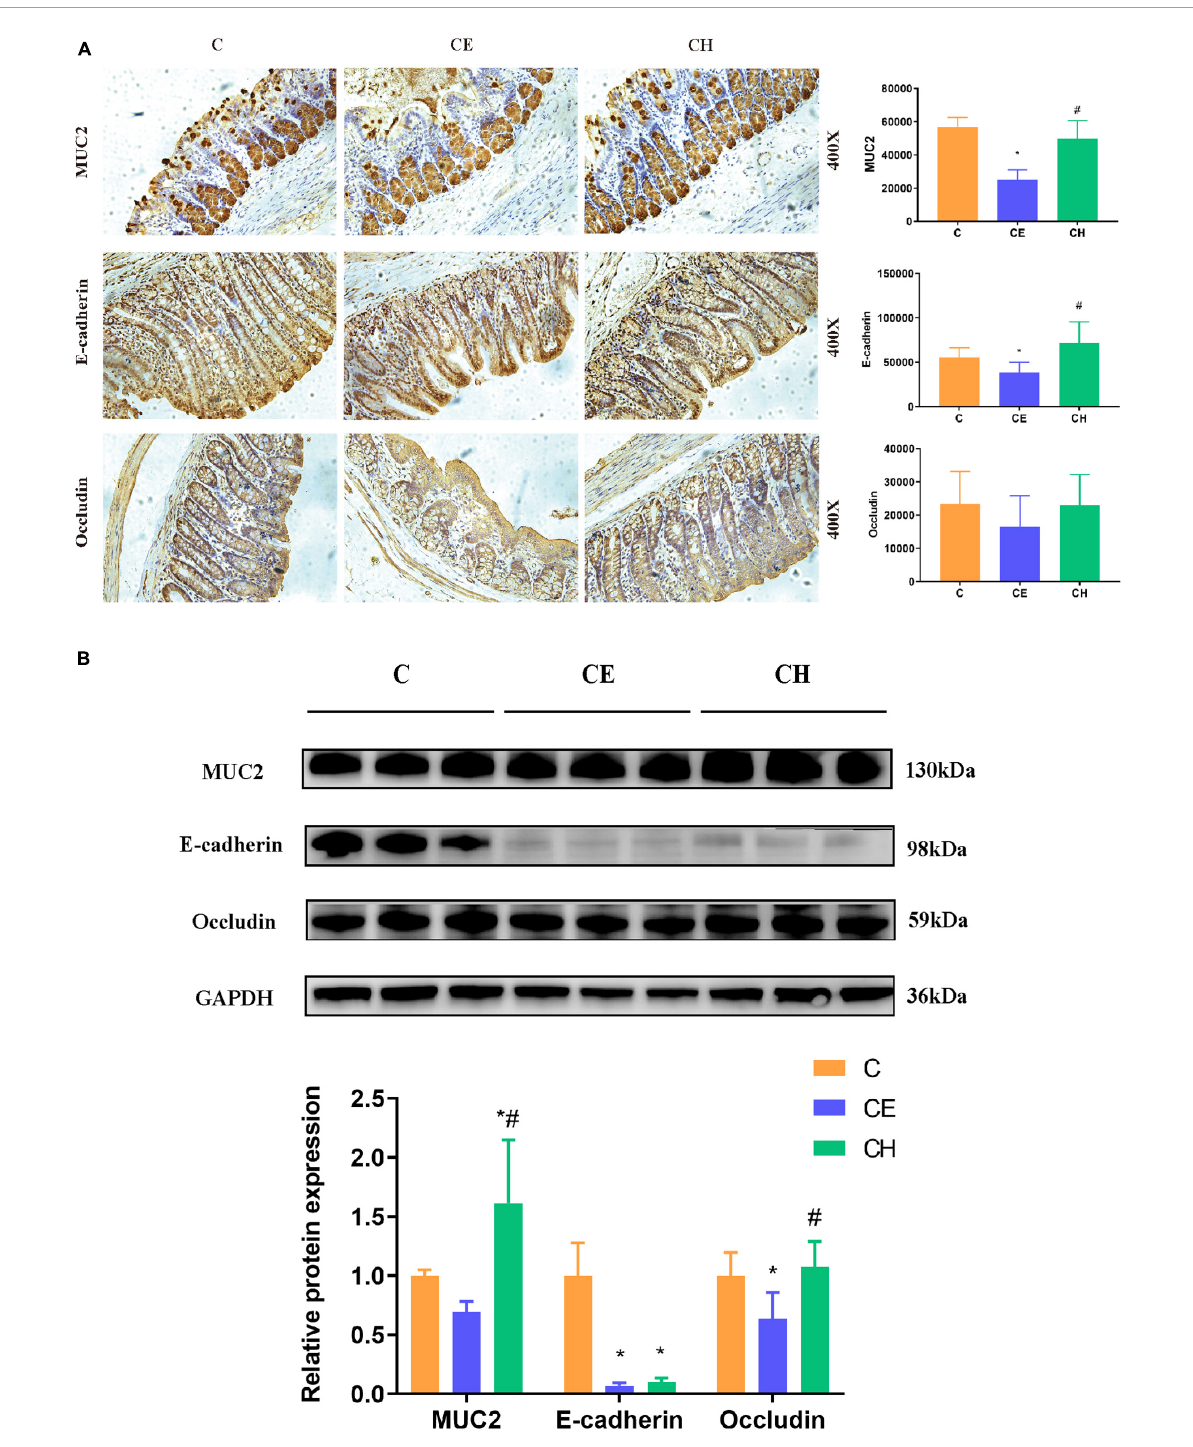
FIGURE6 Protein expression of MUC2, E-cadherin, and occludin in the colon of rats treated with Chinese herbs complex for 14 days. (A) Representative images of immunohistochemical staining of MUC2, E-cadherin, and Occludin in colon samples from different experimental groups (scale bar, 250 mm). Data are presented as the mean ± standard deviation ( n = 5), analyzed using one-way ANOVA with LSD post-hoc analysis. (B) Western blotting for E-cadherin, MUC2, occludin, and GAPDH; relative quantification of E-cadherin, MUC2 and occludin. Data are presented as the mean ± standard deviation ( n = 3). The means with different superscript letters are significantly different based on one-way ANOVA with Dunn-Bonferroni post-hoc analysis; *Means are significantly different vs. C group (* p < 0.05); # Means are significantly different vs. CE group ( # p < 0.05); C, control group; CE, cold exposure group; CH, Chinese herbs complex